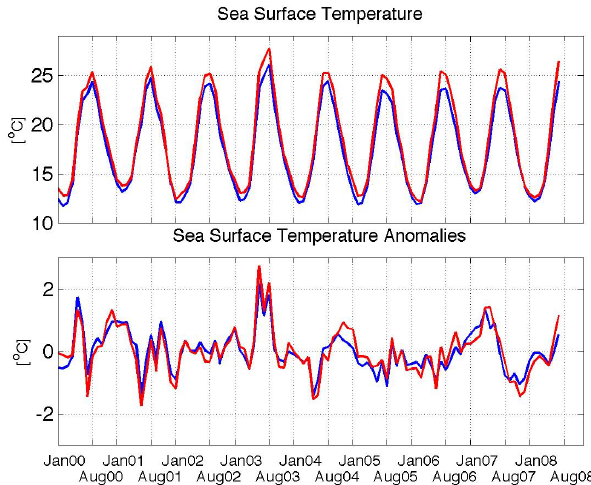
Fig. 8. Top panel: monthly time series of satellite (red line) and modelled (blue line) Sea Surface Temperature. Bottom panel: monthly time series of satellite (red line) and modelled (blue line) Sea Surface Temperature